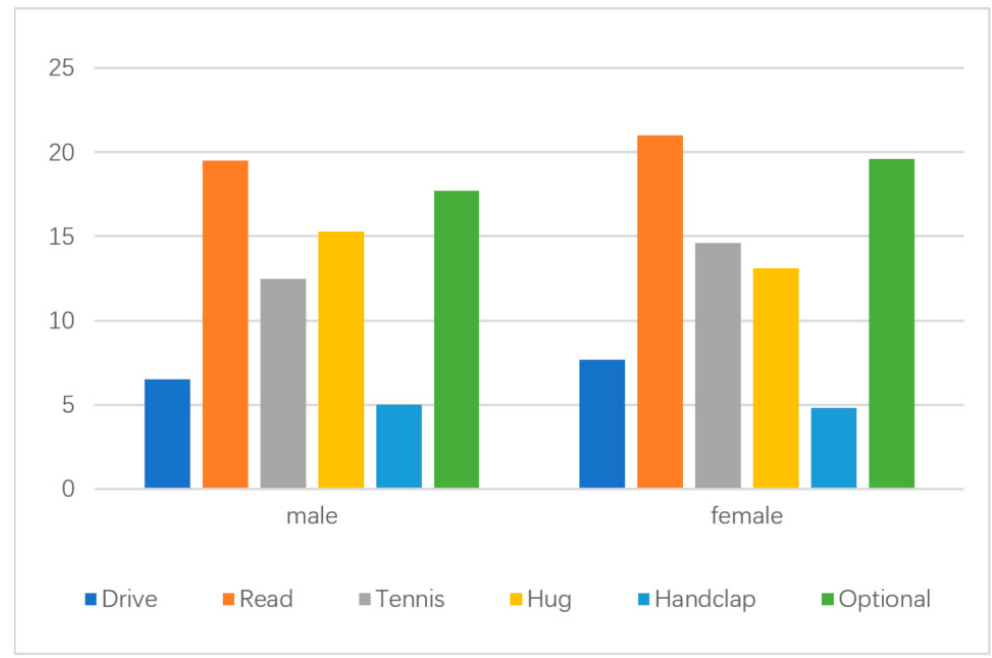
Figure 9. Mean action recognition time of males and females.